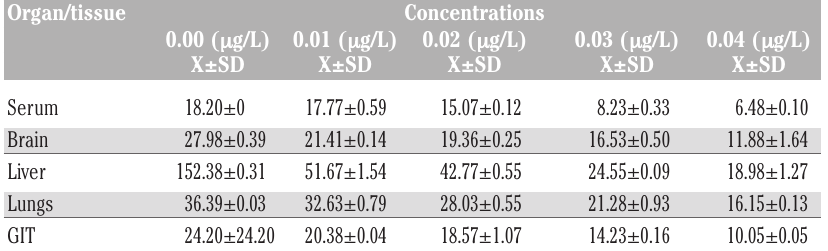
Table 3. Total protein levels (mg/100 mL) in tissues of Bufo regularis exposed to diazinon for 28 days